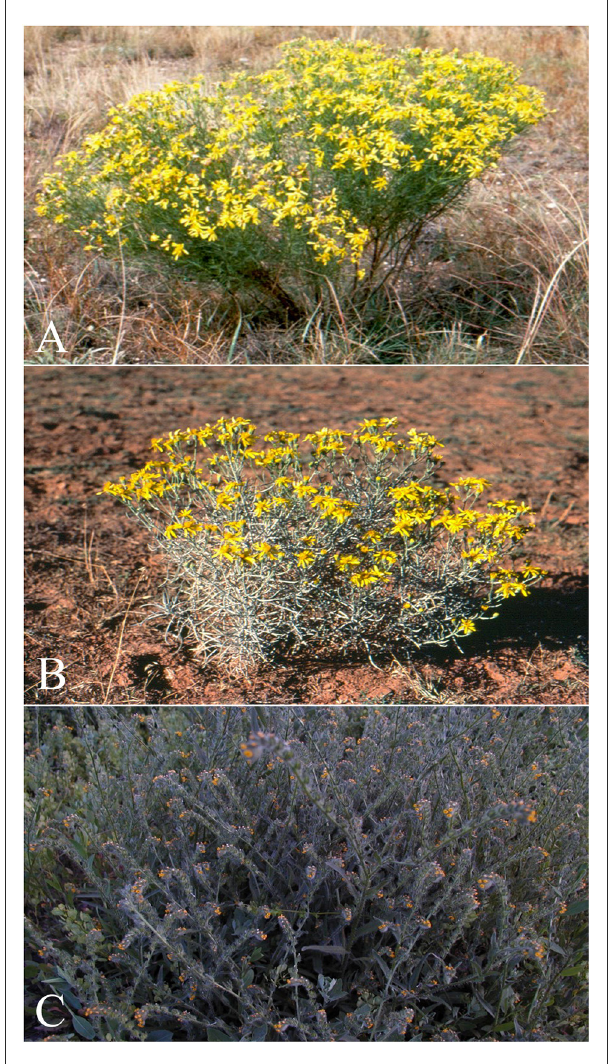
FIGURE9 Dehydro-pyrrolizidine alkaloid (PA) containing plants that commonly poison livestock in North America. (A) Senecio riddellii is found in the central United States and most commonly poisons cattle. This plant is unique, in that it primarily contains a single dehydropyrrolizidine alkaloid (PA), riddelliine, whereas most PA containing plants contain mixtures of various PAs. Riddelliine has been proven carcinogenic to rodents and is classified as a potential human carcinogen by the national toxicology program. (B) Senecia douglasi var. longilobus (threadleaf or wooly groundsel) is found in several southwestern states. The plant contains four different PAs, and most commonly poisons cattle. Wooly groundsel grows well on abused or arid rangelands. And (C) Amsinckia intermedia , (tarweed or fiddleneck) is found throughout Canada and the western, midwestern and northeastern United States, and poisons cattle and horses. This plant has been reported to cause the clinical syndromes “walking disease” in horses and “hard liver disease” in cattle. It commonly grows in waste areas and along field margins.